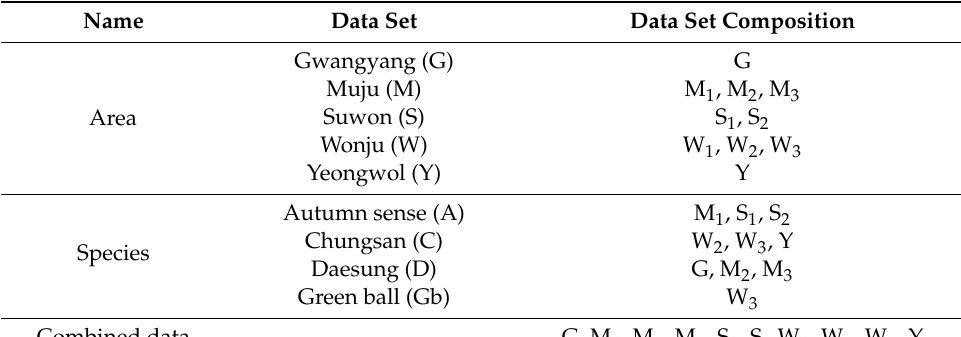
Table 2. Compositions of area, species, and combined